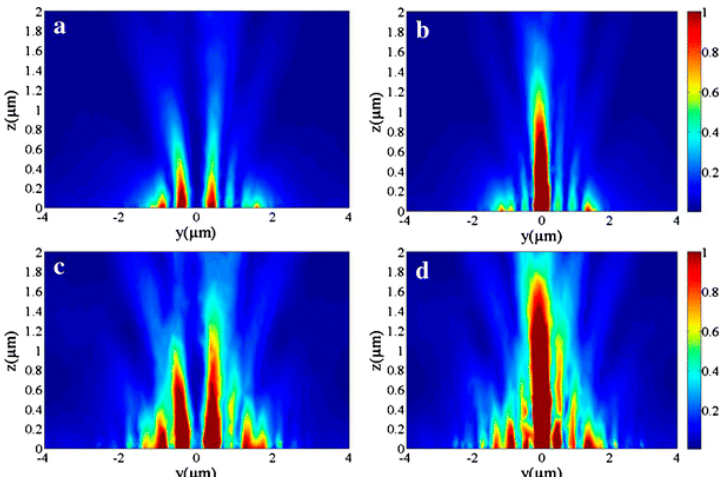
Figure 11. | E | 2 distribution in the z - y -plane for the left-hand spiral plasmonic lens. Top column ( a , b ): Pure single-turn left-hand ASS; bottom column ( c , d ): left-hand ASS surrounded by left-hand Archimedes’ spiral grating (ASG) on both sides of the metal film; ( a , c ) LCP illumination; ( b , d ) RCP illumination. Reproduced with permission from [28]. Copyright Springer, 2015.